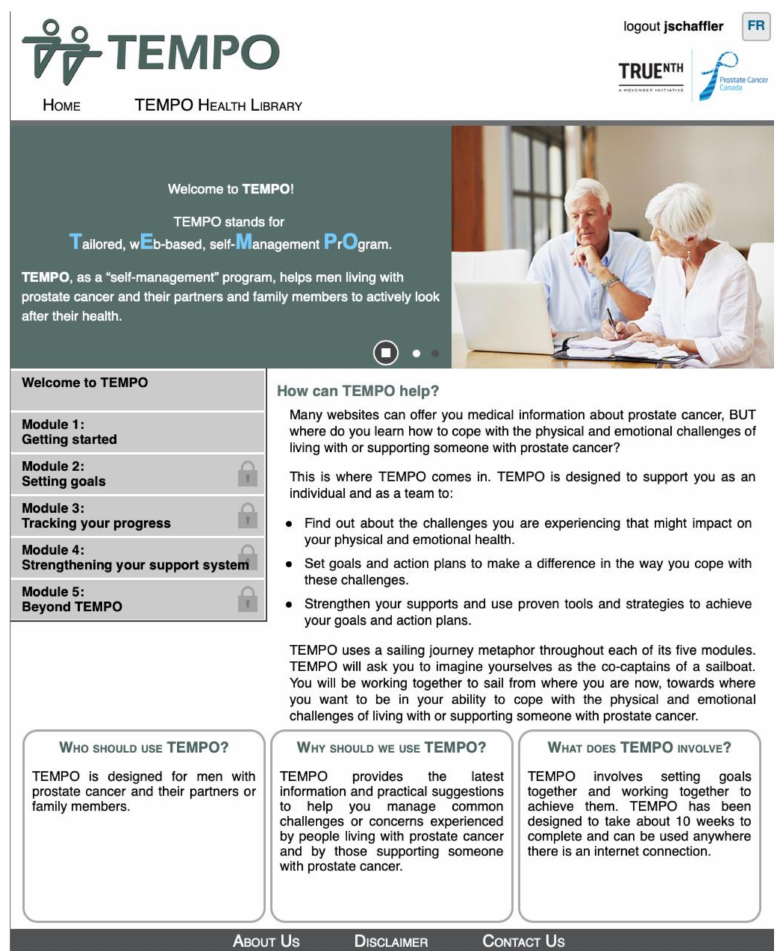
Figure 2. TEMPO landing page. This figure illustrates the navigational features of TEMPO including the introduction, the five modules dyads completed, and the health library